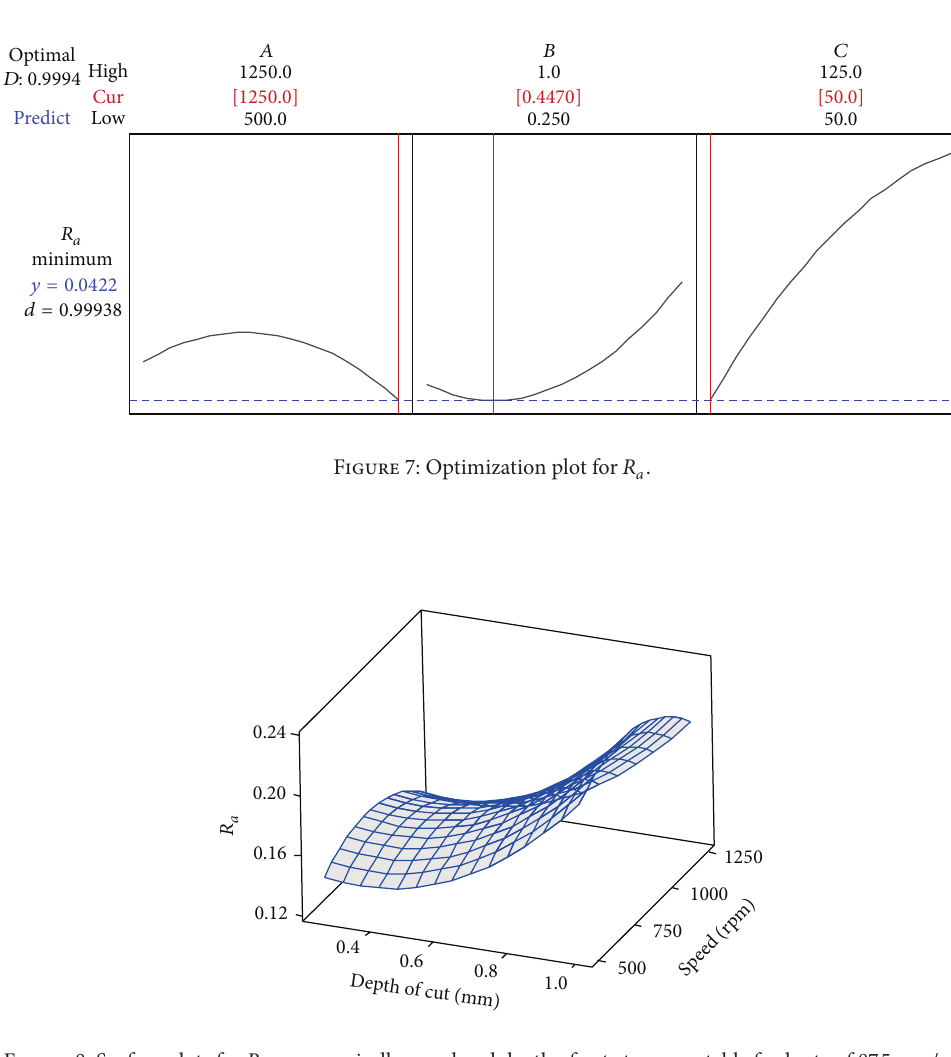
Figure 8: Surface plots for 𝑅 𝑎 versus spindle speed and depth of cut at a mean table feed rate of 87.5 mm/min.